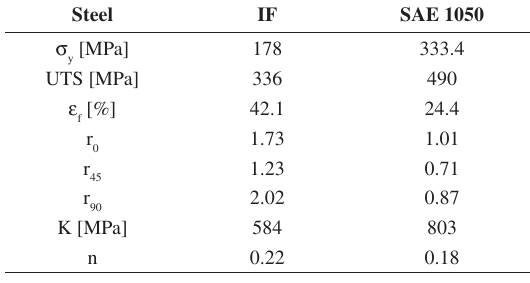
Table 2. Base mechanical properties of the investigated